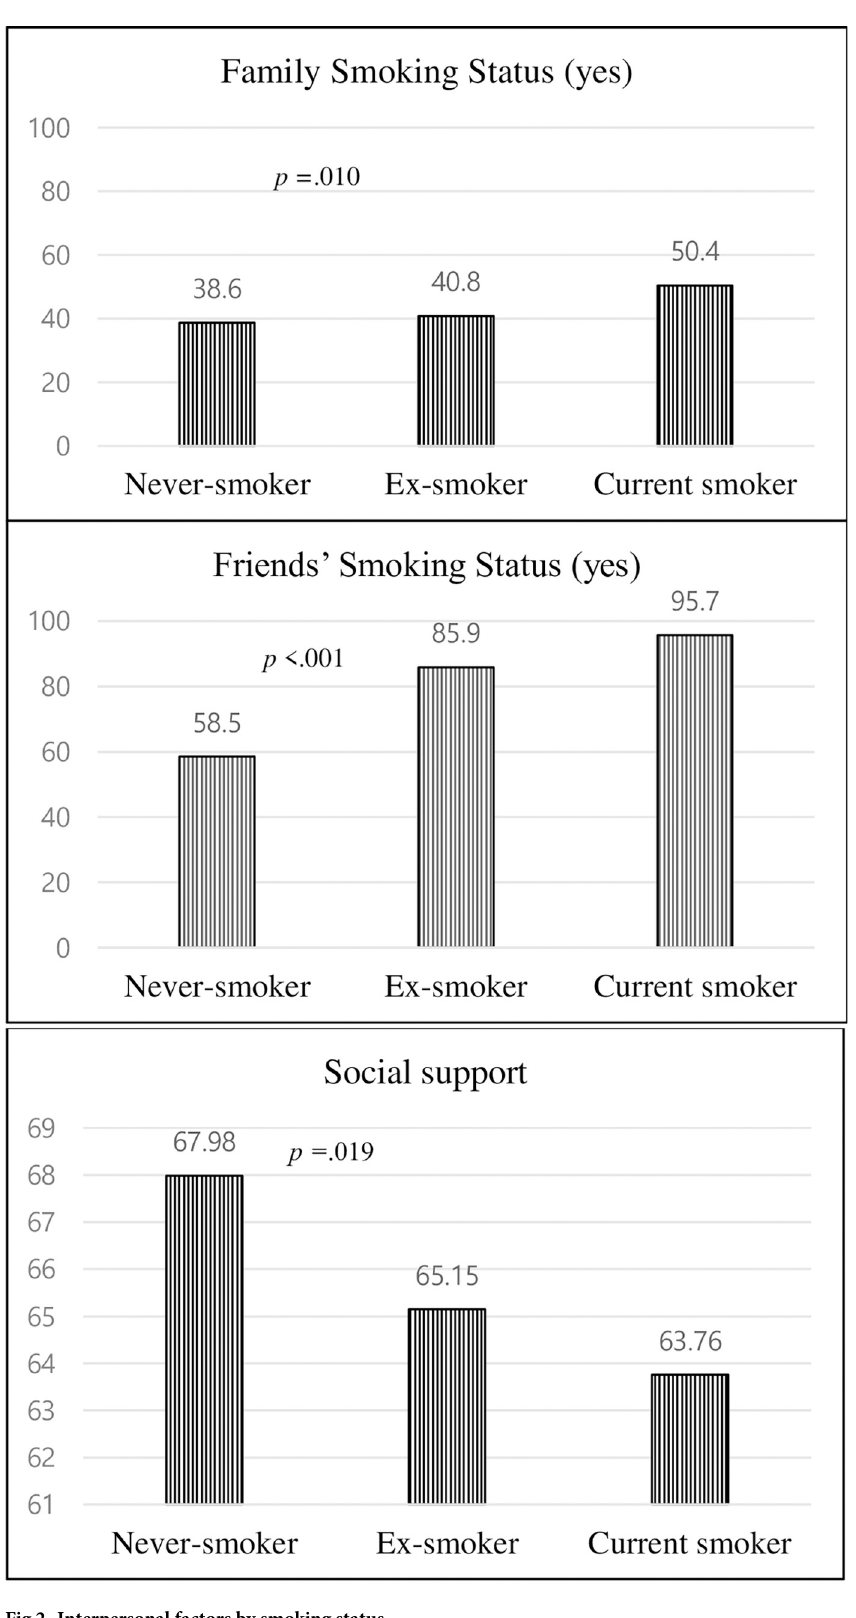
Fig 2. Interpersonal factors by smoking